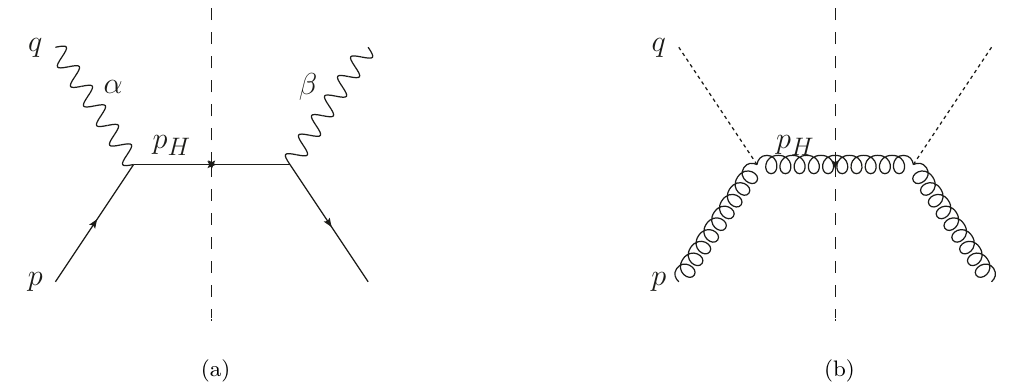
Figure 1. LO squared amplitudes for: (a) DIS; (b) Higgs-induced DIS, where the Higgs boson couples to the gluon via an effective